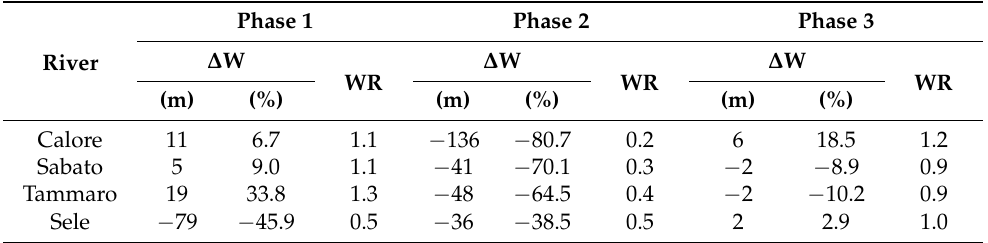
Table 4. Channel mean width variations (expressed both in meters and percent) and width ratio (WR) values of the investigated rivers in the considered